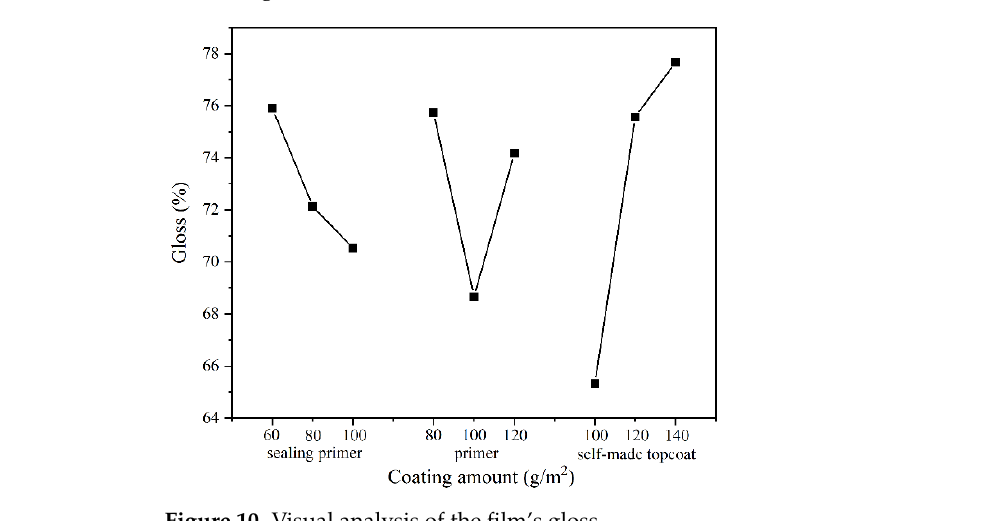
Figure 10. Visual analysis of the film’s gloss. Table 6. Variance analysis of the